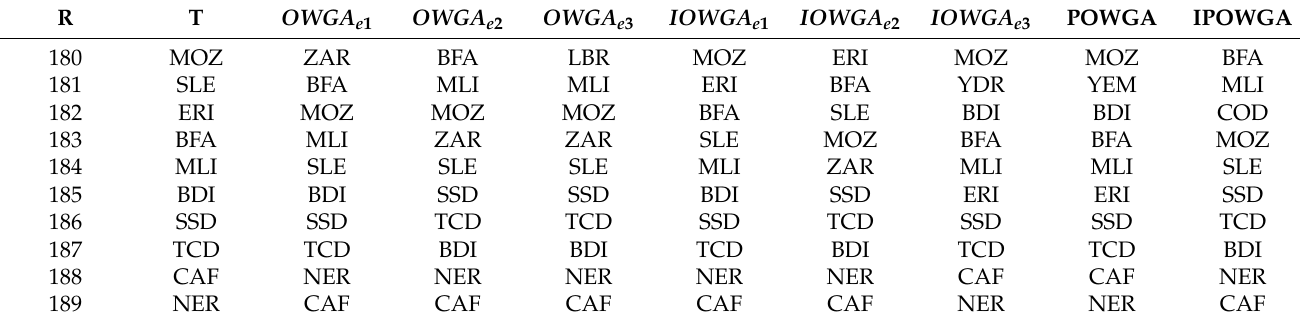
Table 5. Worst 10